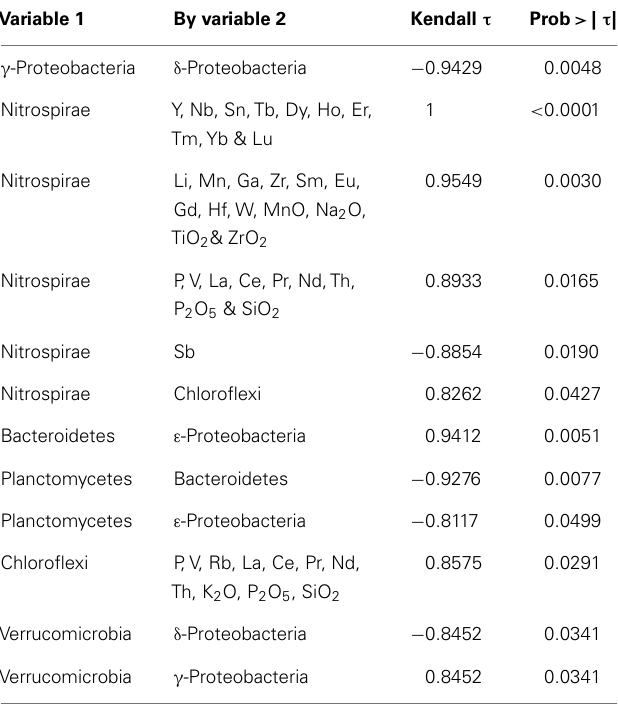
Table 4 | Kendall’s τ correlations between elemental data and bacterial